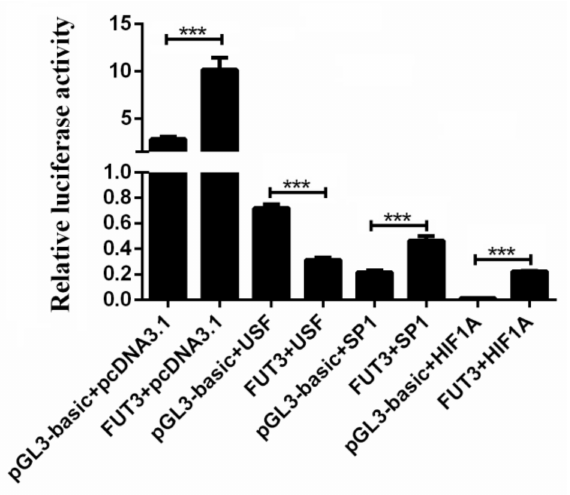
Figure 6. Effects of HIF1A, SP1, and USF on FUT3 transcriptional activity by dual-luciferase activity assay. The obtained results are indicated as mean ± SEM, *** p <